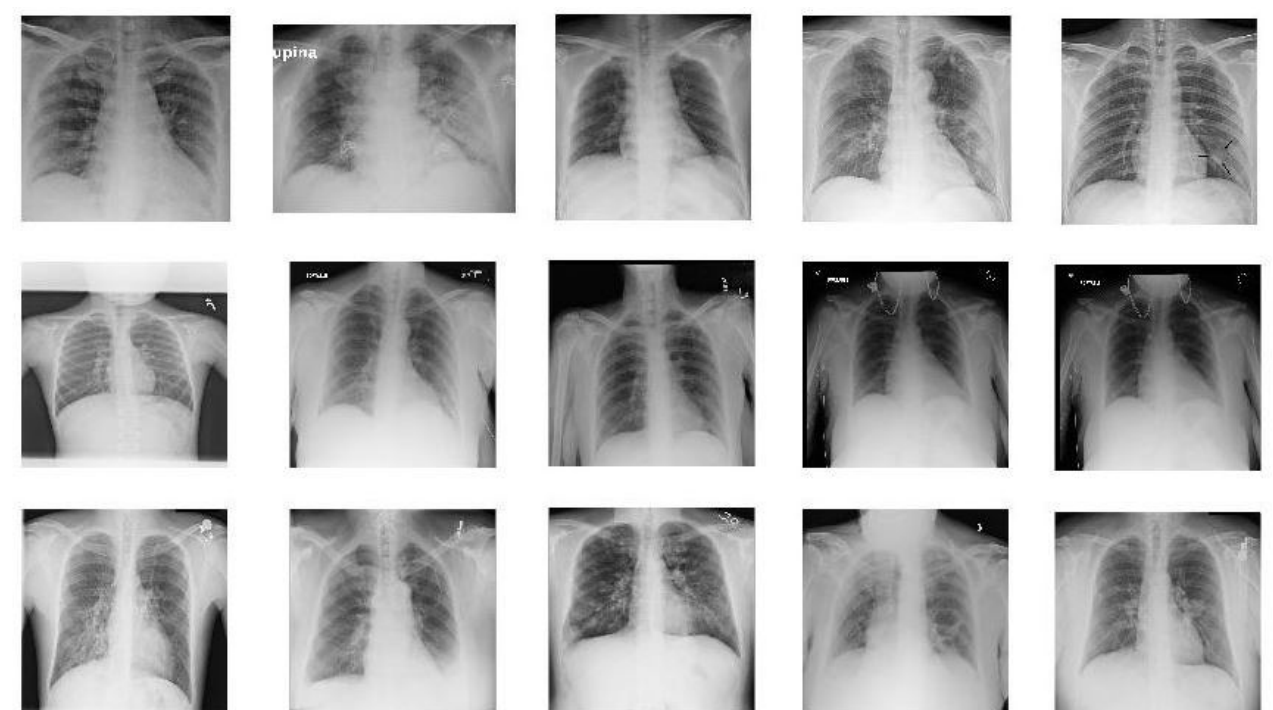
Figure 1. Sample images from X-ray dataset. The images in the first row show 5 COVID-19 images. The images in the second row are 5 sample images of no-finding category in Non-COVID images. The images in the last row give 5 sample images from Pneumonia.